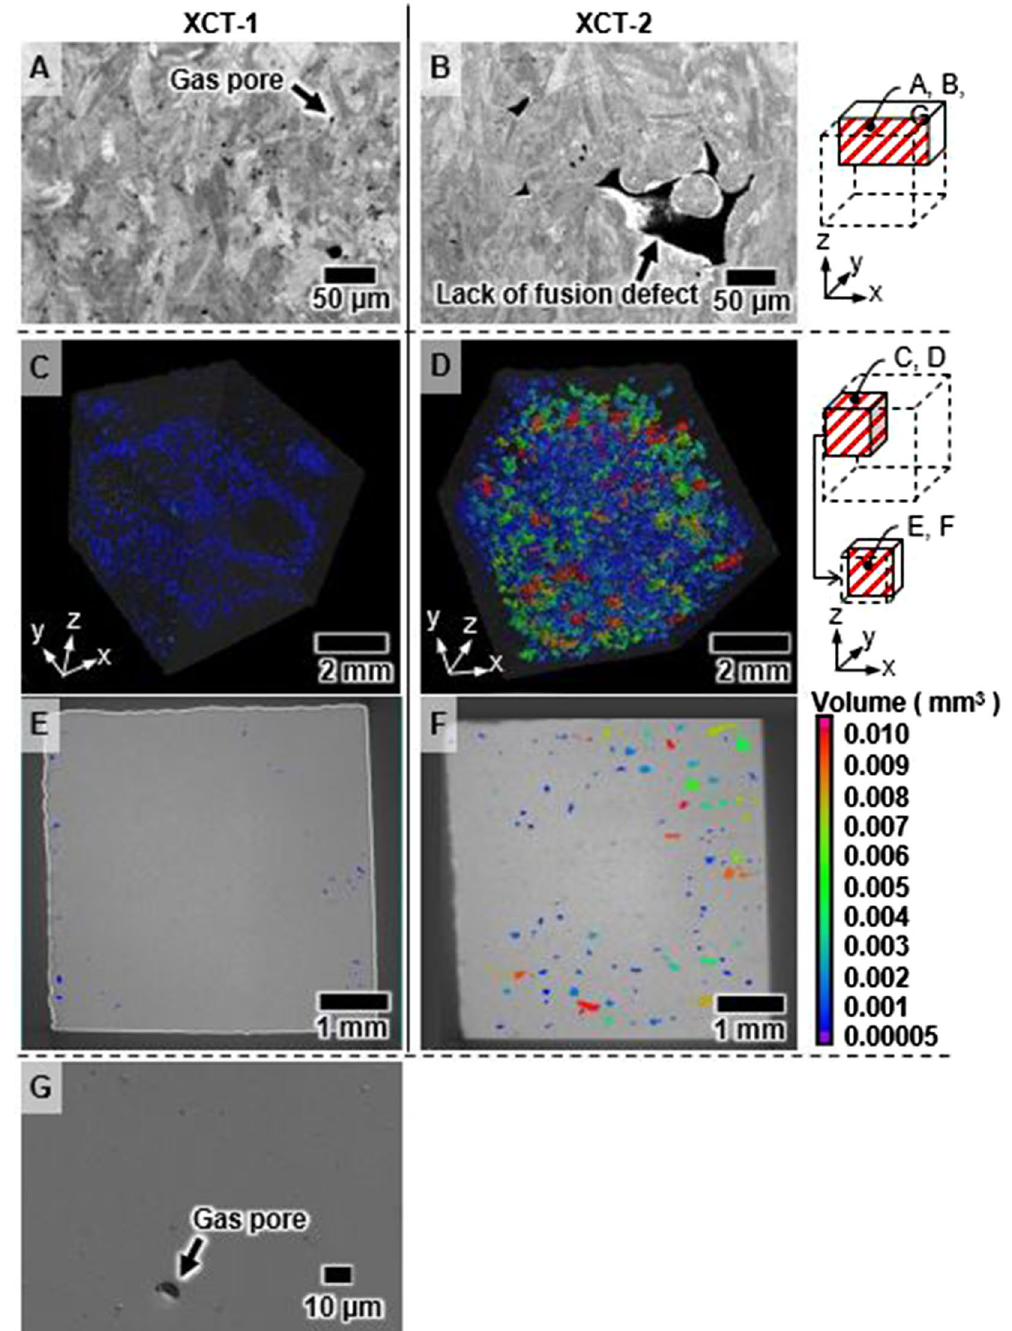
Figure 2. Observation of internal defects in cubic specimens—( A , C , E ) X-CT1 images with E = 43.5 J/mm 3 , D = 100.1%; ( B , D , F ) X-CT2 images with E = 29.0 J/mm 3 , D = 98.3%. ( A ) and ( B ) depict SEM images of cubic- specimen cross-sections; ( C ) and ( D ) depict 3D XCT images; ( E ) and ( F ) depict 2D XCT images. ( G ) Image with D = 99.7%. Images created using PC-SEM Ver.5.1.0.11 (https:// www. jeol. co. jp/) and VGStudio MAX Ver.3.4 (https:// www. volum egrap hics. com/ jp/ produ cts/ vgsm.